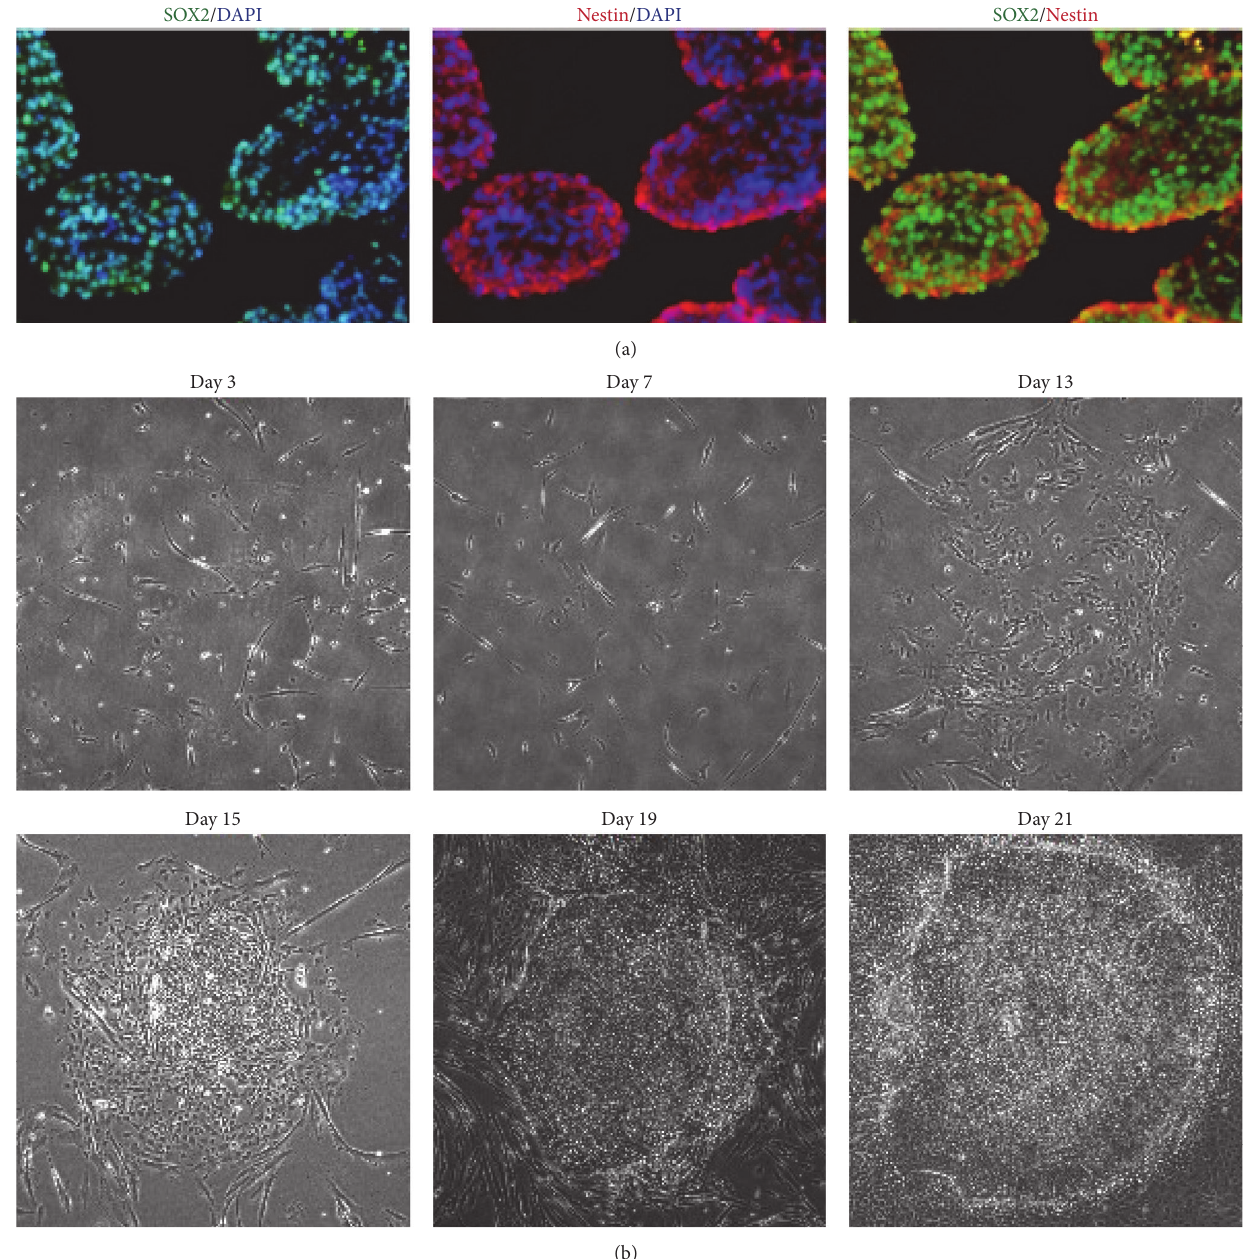
Figure 1: SOX2 and Nestin were endogenously expressed in human NSC or NPCs. (a) SOX2 (green) and Nestin (red) were endogenously expressed in human NSC or NPCs. Nuclei were stained with DAPI (blue). (b) Reprogramming process of NPCs under phase contrast microscopy. Scale bars, 50 𝜇